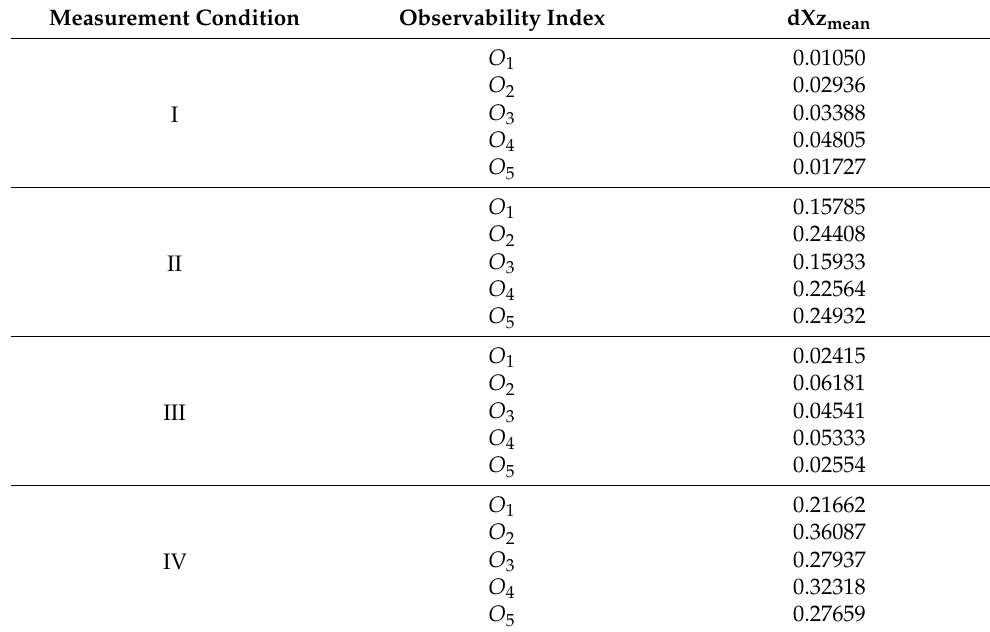
Table 4. Mean integrated error of calibration with five observability